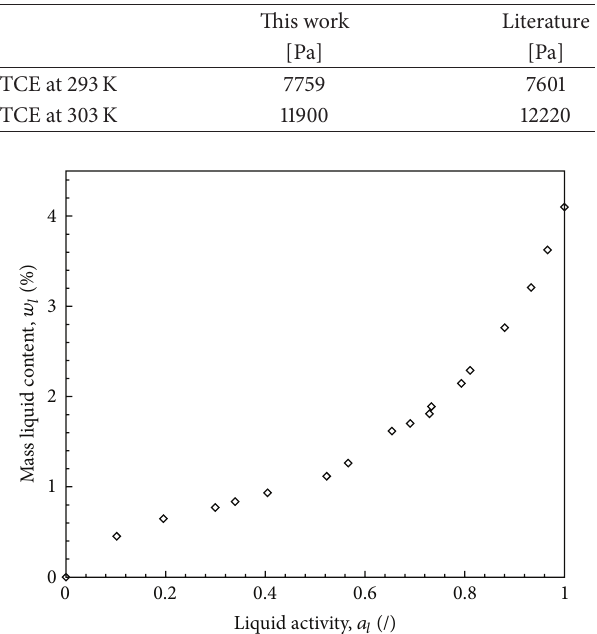
Table2:SaturatingvaporpressuresofTCEatdifferenttemperatures [25].